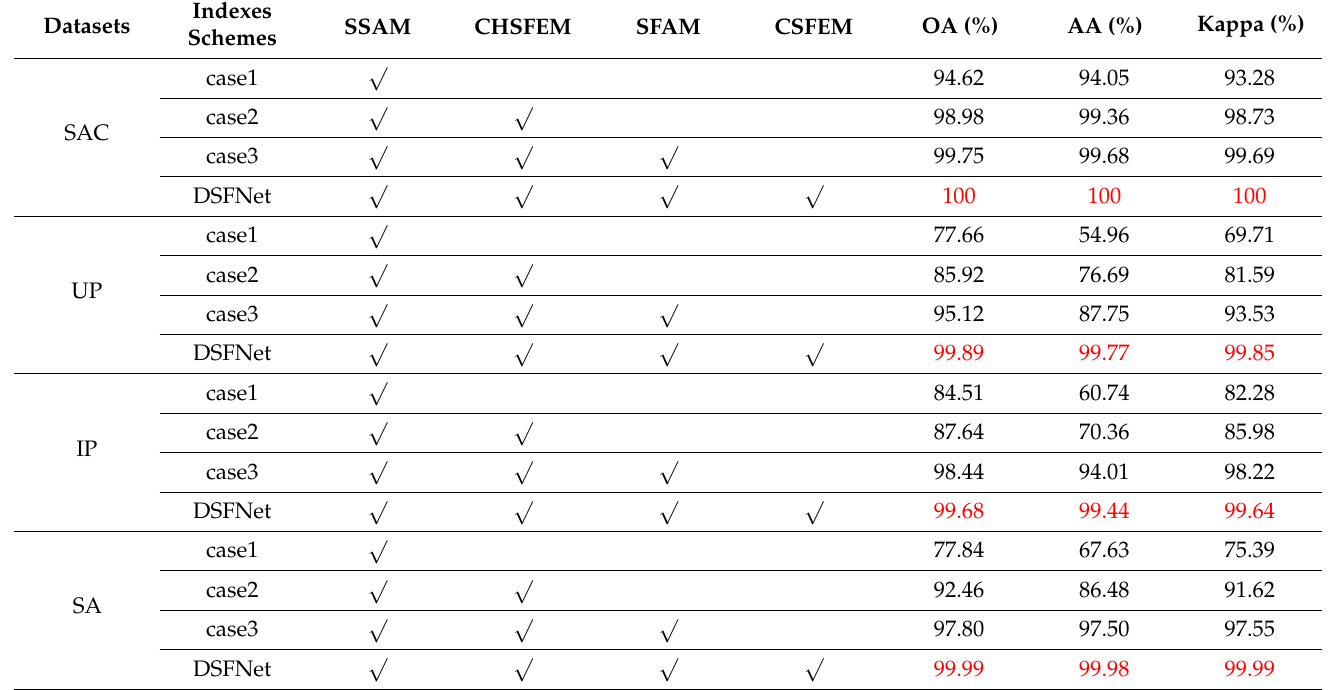
Table 11. Effectiveness analysis of the proposed DSFNet on the four experimental